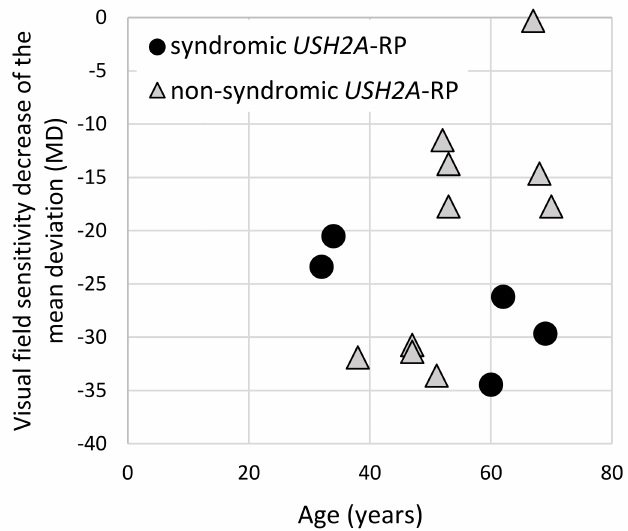
Figure 6. Correlation of the visual field changes and age of syndromic and non-syndromic USH2A -RP patients. The vertical line shows the mean deviation value (MD) which was obtained from HFA and the horizontal one shows age of patient. One dot represents each patient and round dots and triangle dots indicate syndromic ( n = 5) and non-syndromic ( n = 10) USH2A -RP patients, respectively.